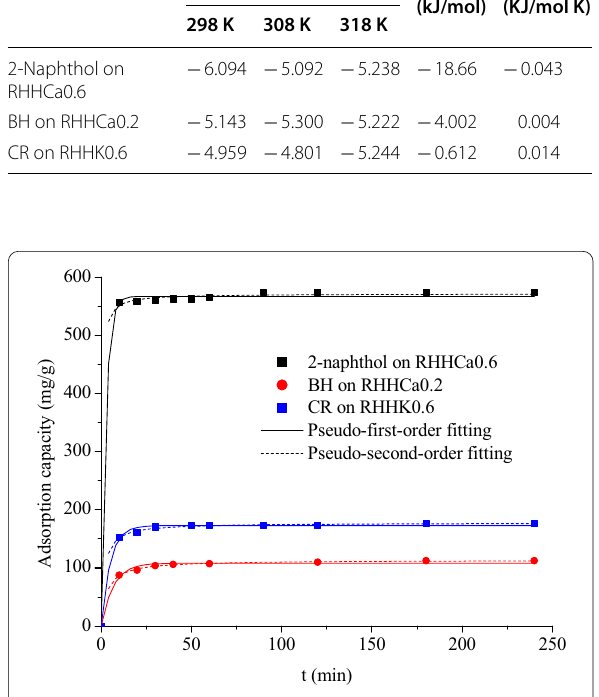
Fig. 7 Adsorption kinetics of a 2-naphthol on RHHCa0.6; b BH on RHHCa0.2 and c CR on RHHK0.6 at 298